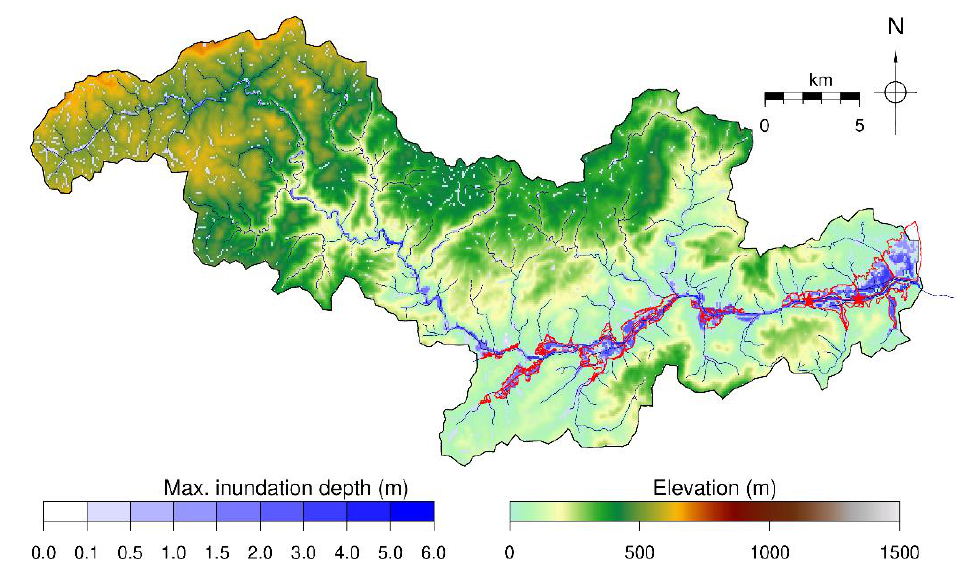
Figure 9. The maximum inundation flood depth profile over the Oda river basin that takes into account embankment bursting and the backwater effect. Red polygons are the estimated flood-inundated area based on GSI maps.